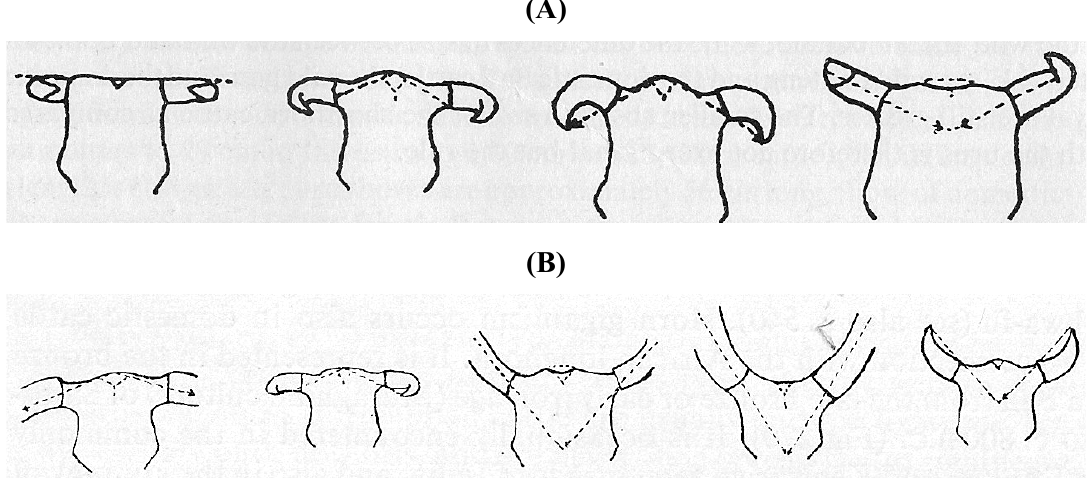
Figure 3. Types of crania and horn implant after Duerst (shown in [15], pp 239, 320). ( A ) Variation in the shape of the Torus frontalis and intercornual ridge as depending on the direction of the horns. ( B ) Horn shapes combined with a long processus cornu